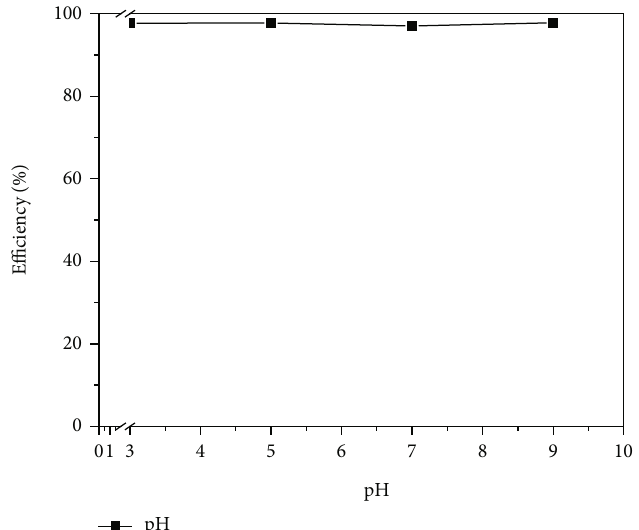
Figure 2: E ff ect of pH on percentage removal of Cr(VI) by SSAC ( Co = 30 mg/L ; adsorbent dose 15g; agitation speed = 120 rpm ; time = 180minutes ).